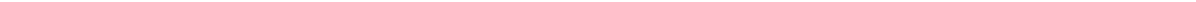
Fig. 5 Mef2c -het mice exhibit altered synaptic properties and E/I imbalance in synaptic neurotransmission. a Immunohistochemistry of synaptophysin (SYP), VGLUT1, and VGAT in WT and Mef2c -het hippocampus. Scale bars: 500 µ m (top panel), 50 µ m (middle and bottom panels). b Reduced immunoreactivity of SYP in the dentate gyrus (DG) and CA1 regions of Mef2c -het hippocampus but not cortex (Ctx) or striatum (str, left). DG measurements were performed in the molecular layer, CA1 in the pyramidal cell layer, Ctx in frontal cortical layers IV and VI, and str in the putamen at the level of the nucleus accumbens. Reduced expression of VGAT but not VGLUT1 in Mef2c -het hippocampus (right). Data are mean ± s.e.m., n = 4 per group; * P < 0.05, ** P < 0.01 by Student ’ s t test. c , d Representative traces of mIPSCs ( c ) and mEPSCs ( d ) from slice recordings of DG neurons of WT and Mef2c - het mice. e – h Cumulative plots of mIPSC and mEPSC amplitude and inter-event intervals. n = 7 – 9 per genotype; ** P < 0.01 by